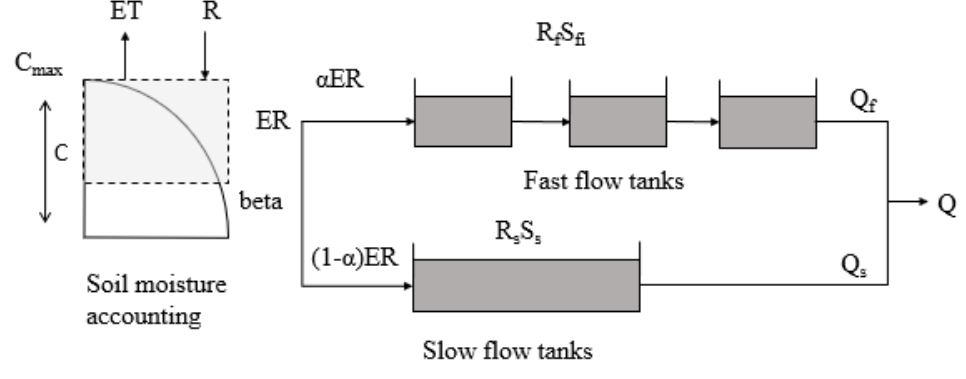
Figure 5. Diagram of Hymod model. Table 2. Description and ranges of parameters in Hymod model.